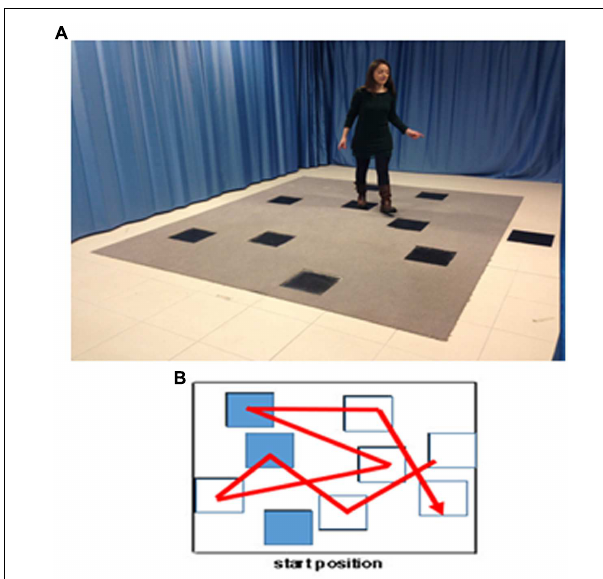
FIGURE 2 | Outline of the Walking Corsi